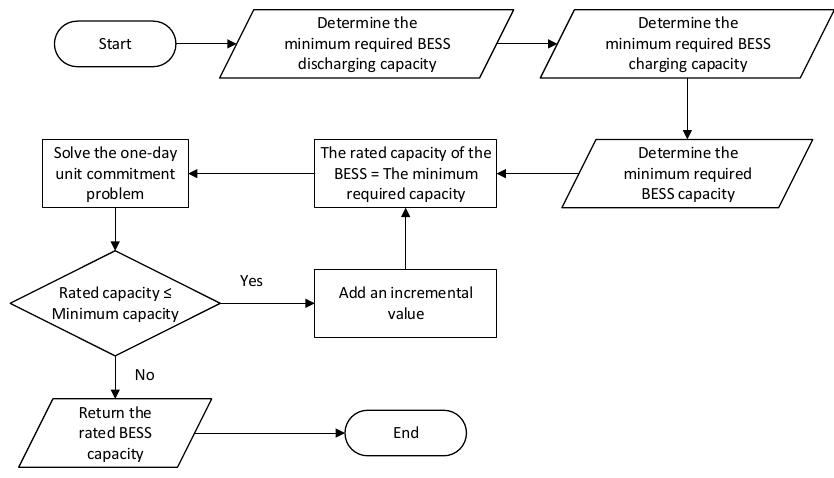
Figure 4. The flowchart of the proposed